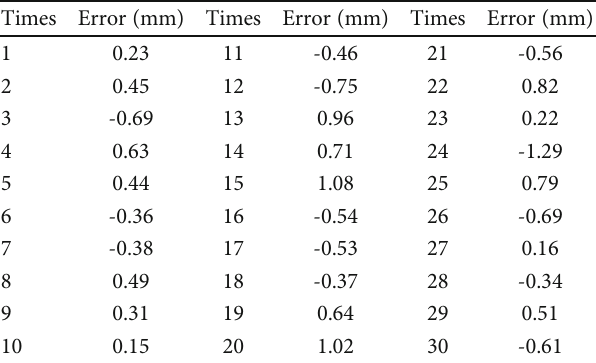
Table 6: Positioning error of hydraulic rod at 3mm/s speed.